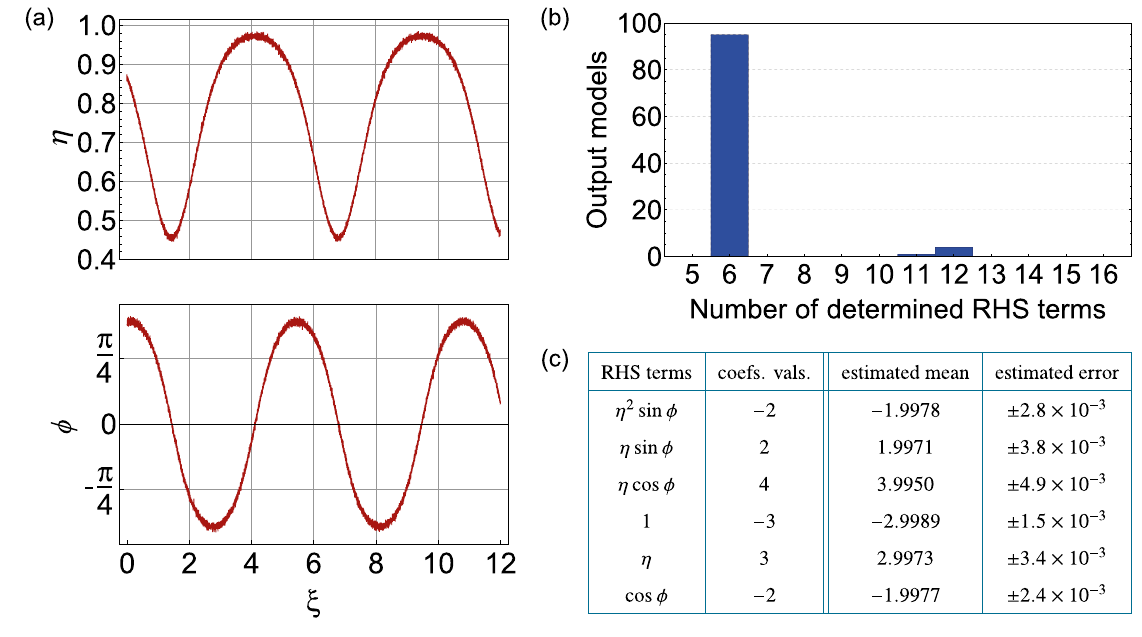
Figure 4. Input data and results returned by SINDy when analysing data with 2.5% noise. ( a ) Typical noisy data input to SINDy showing η ( ξ ) and ϕ ( ξ ) evolution for initial conditions η 0 = 0.87, ϕ 0 = 1.2 ( b ) Histogram showing the number of returned terms from applying SINDy to 100 data sets. ( c ) Computed mean and standard deviation of the coefficients of the 6-term models, compared with values expected from the ideal system in Eq. (1). The threshold here was λ =